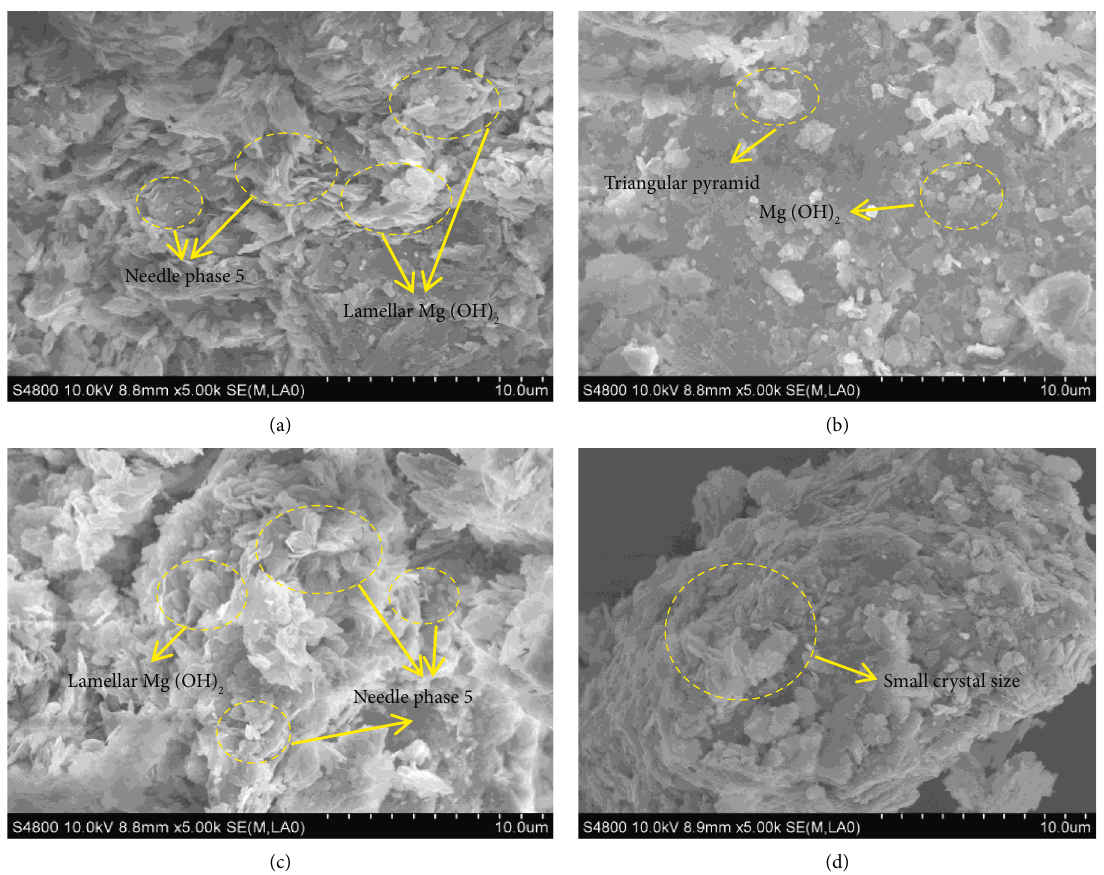
Figure 15: SEM analysis. (a) Sample 1, (b) Sample 2. (c) Sample 3, and (d) Sample